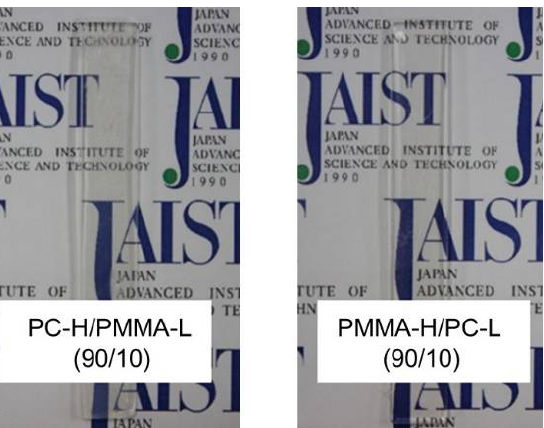
Figure 7. Injection-molded bars of PMMA-H/PC-L (90/10) and PC-H/PMMA-L (90/10). The compositions of the blends at the surfaces of the samples were determined by obtaining their ATR-IR spectra and focusing on the intensities of the peaks attributable to carbonyl stretching vibrations, i.e., 1720–1730 cm − 1 for PMMA and 1770–1780 cm − 1 for PC. Prior to the measurements, the peak intensity ratios were determined using compression- molded films with various blend ratios to obtain a calibration curve. Because KRS-5 was used for the ATR crystal, the penetration depth ( d P ) of the IR beam, calculated using Equation (5) [44,45], was approximately 1